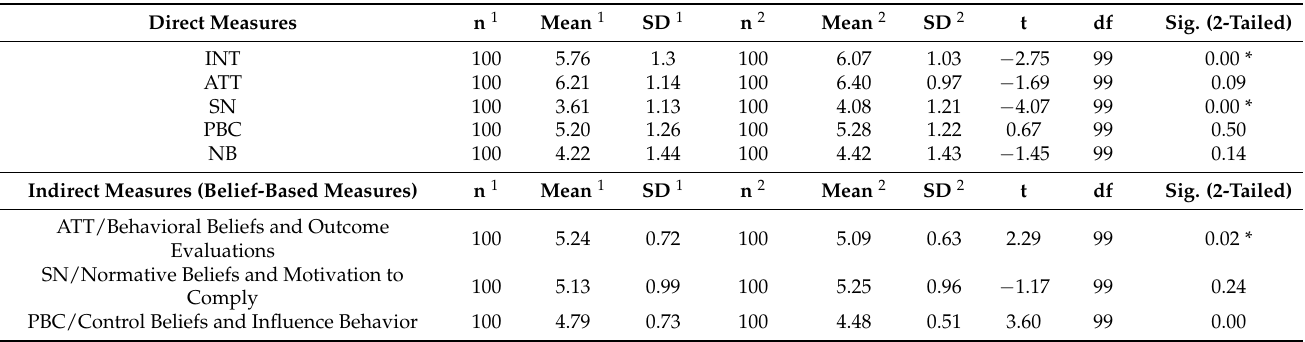
Table 9. Paired Samples Statistics between Pre-feedback and interventions and Post-feedback Scores of the Experimental